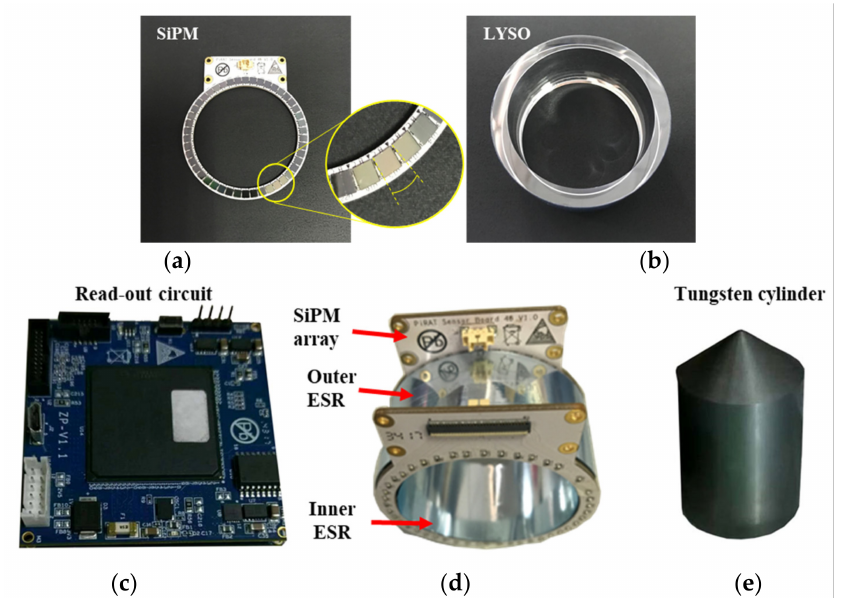
Figure 4. Pictures showing: ( a ) SiPM array ring with 46 SiPMs, ( b ) polished monolithic LYSO scintillator ring, ( c ) custom-designed 100-channel readout electronics system, ( d ) assembled detector module, and ( e ) inserted Tungsten